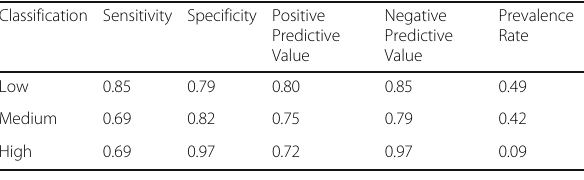
Table 1 (abstract 000164). Model performance